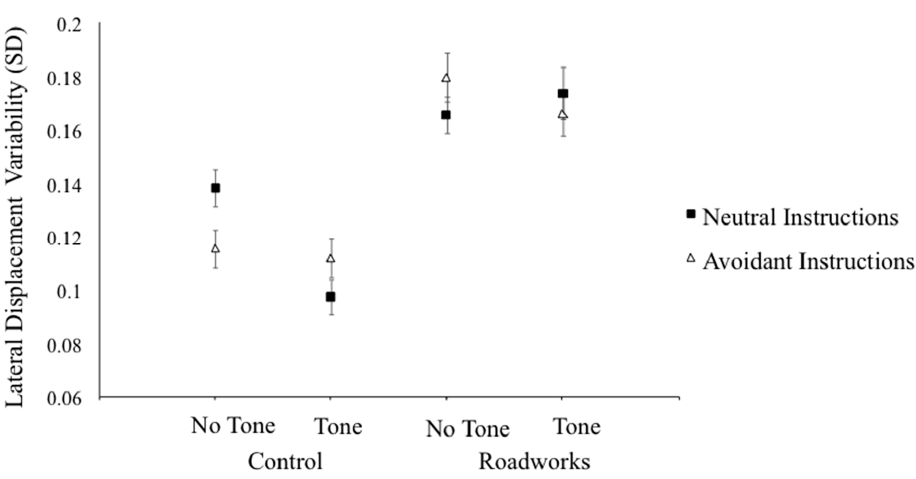
Figure 3. Lateral displacement variability (SD) across the experimental conditions: instructions that were neutral or avoidant, secondary task (tone counting was present or absent), and driving difficulty (with or without roadworks).